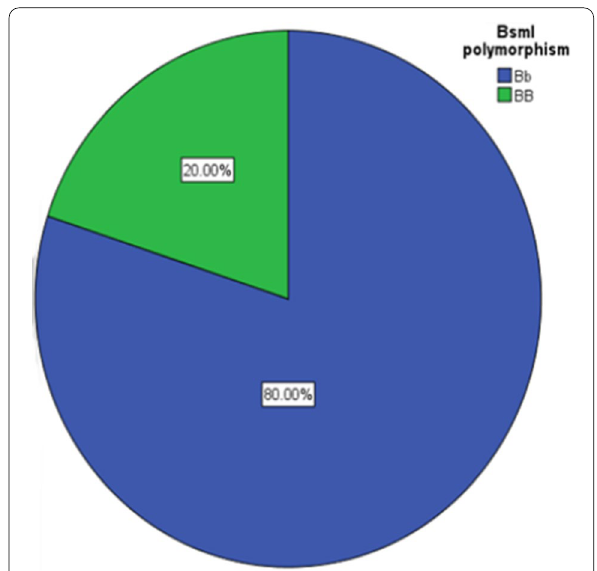
Fig. 2 BsmI gene polymorphism among obese male students